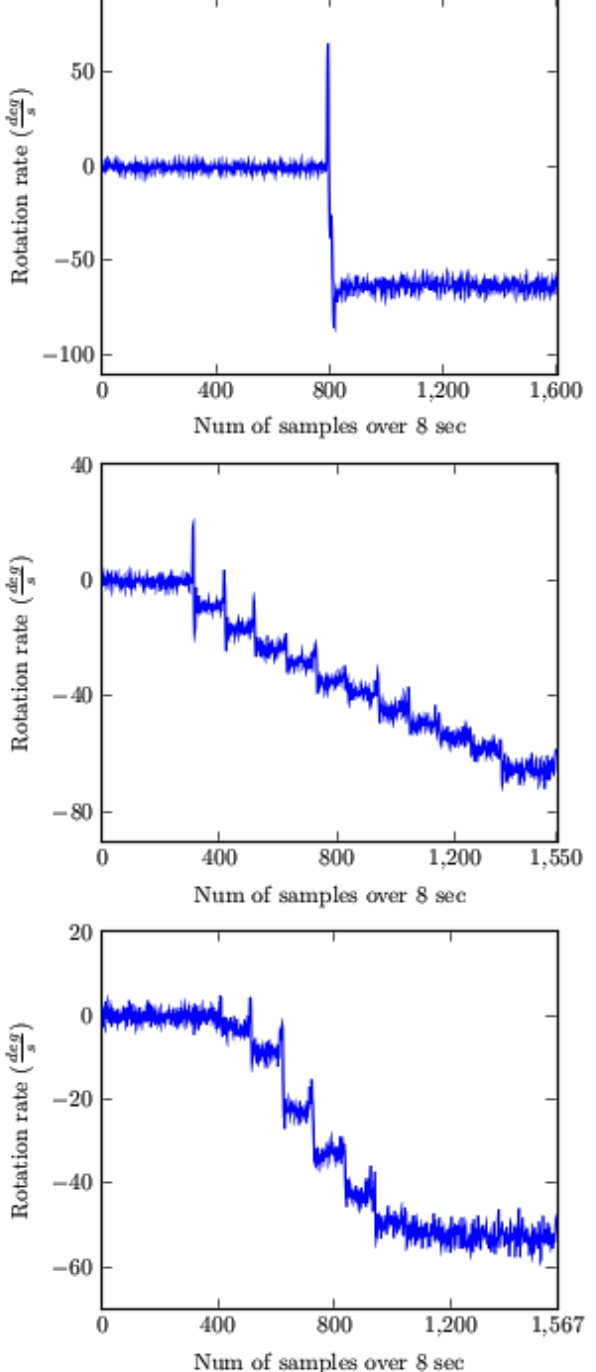
Figure 10. The rotation rate of the three transition cases for the Lego model. Top: no transition; Middle: clothoid transition; Bottom: S-shaped